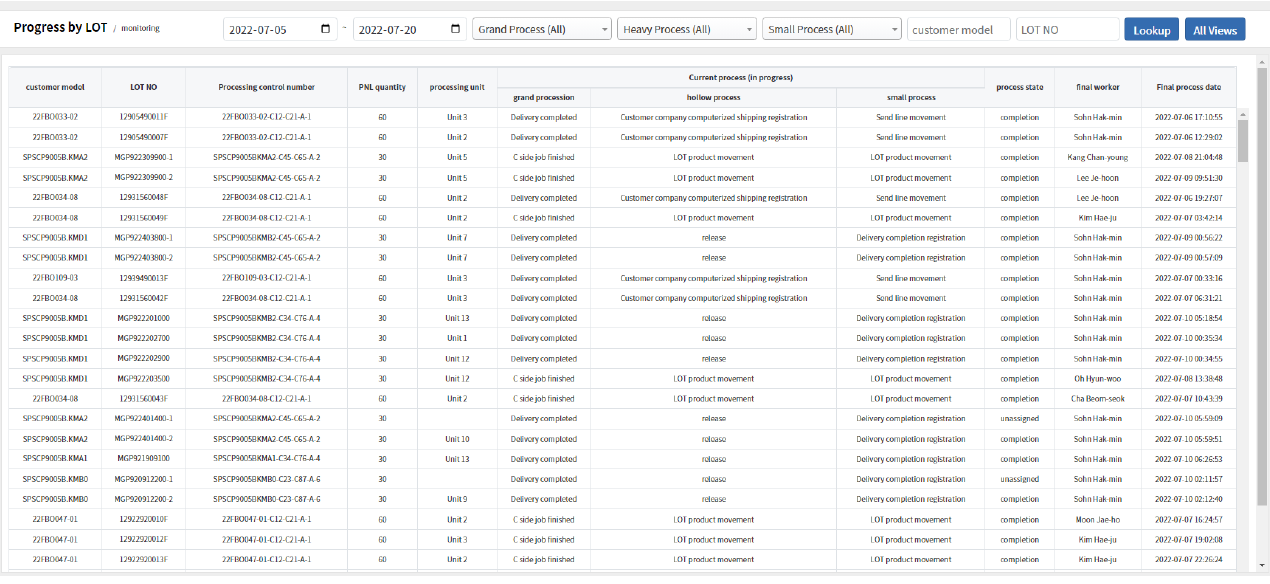
Figure 21. The progress status of each